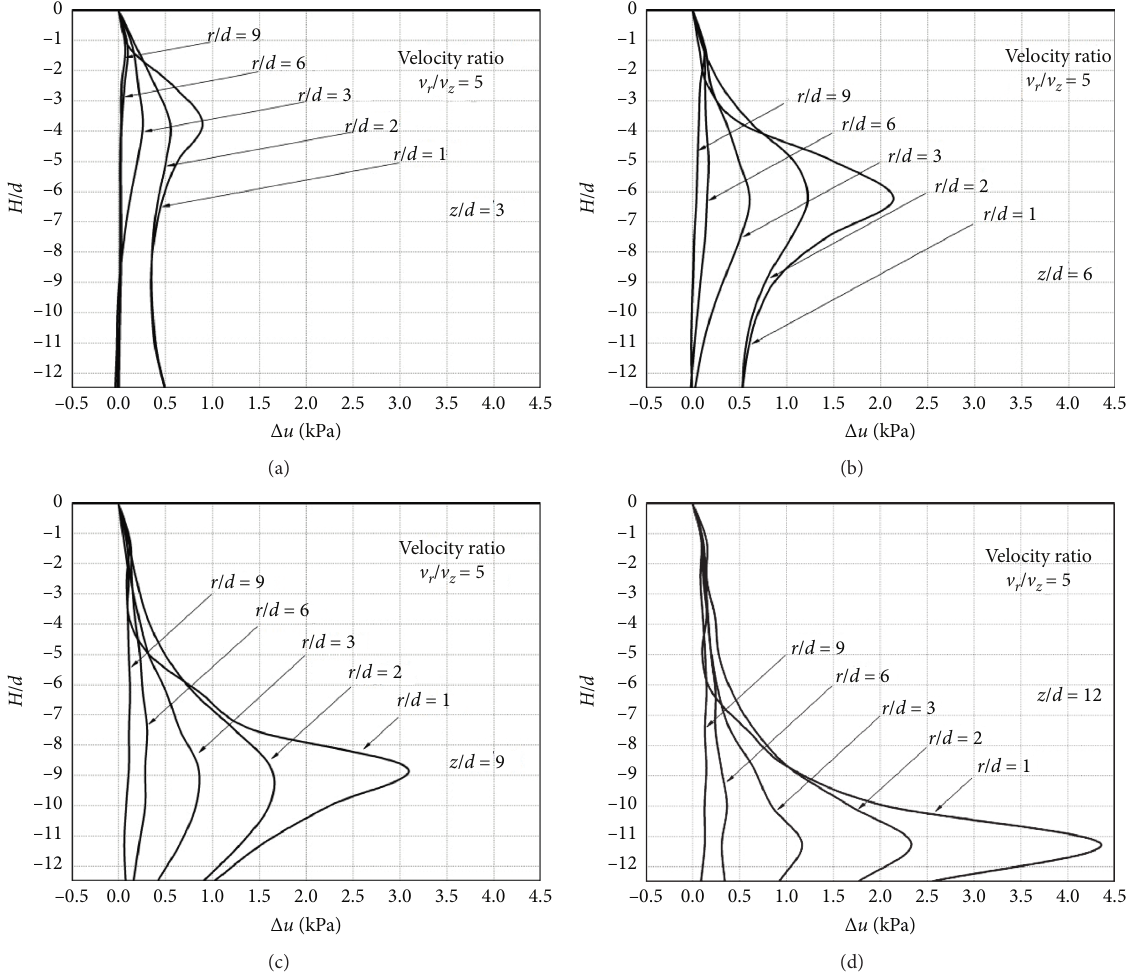
Figure 8: The excess pore water pressure generated during the drilling process of CFG piles.